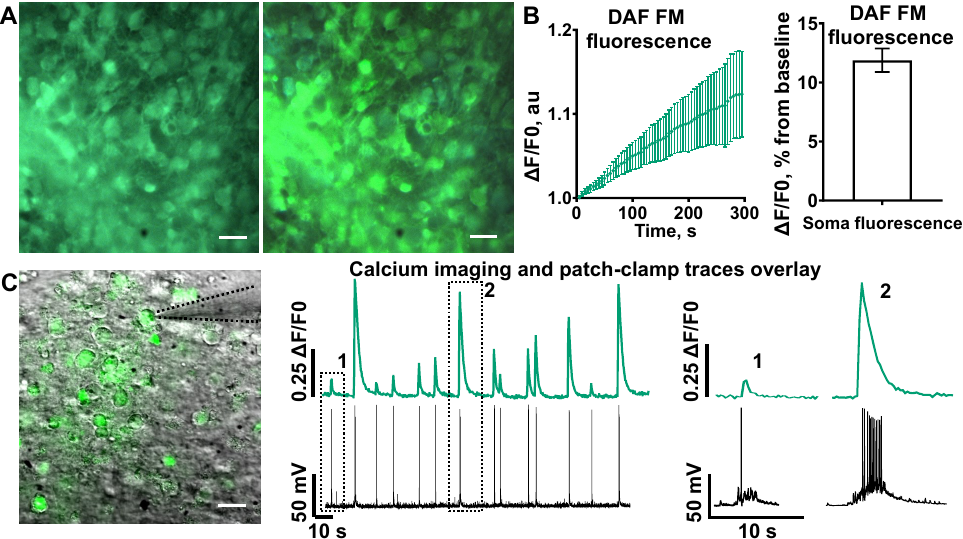
Figure 1. The relationship between number of action potentials, amplitude of calcium events and nitric oxide synthesis. ( A ) Two photos of DAF-FM loaded cells with a 5 min gap. Scale bar—20 µ m. ( B ) Left: fluorescent increase in DAF-FM over 5 min of acquisition. Right: average increase in DAF- FM fluorescence in cell somas after 5 min. ( C ) Left: Oregon Green-brightfield overlay. Black dots show the patch pipette. Middle and right: superposition of calcium imaging trace and patch-clamp trace in current clamp mode from the same cell, with time magnification of single calcium events of different amplitudes.